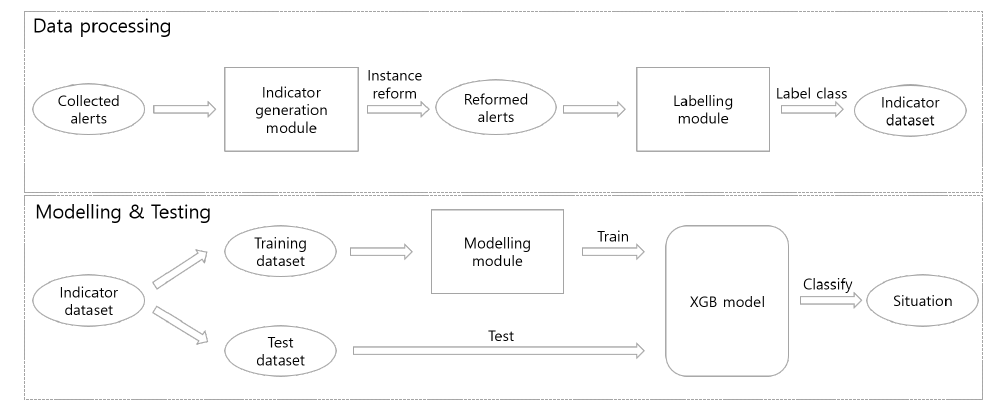
Figure 1. Process of situational